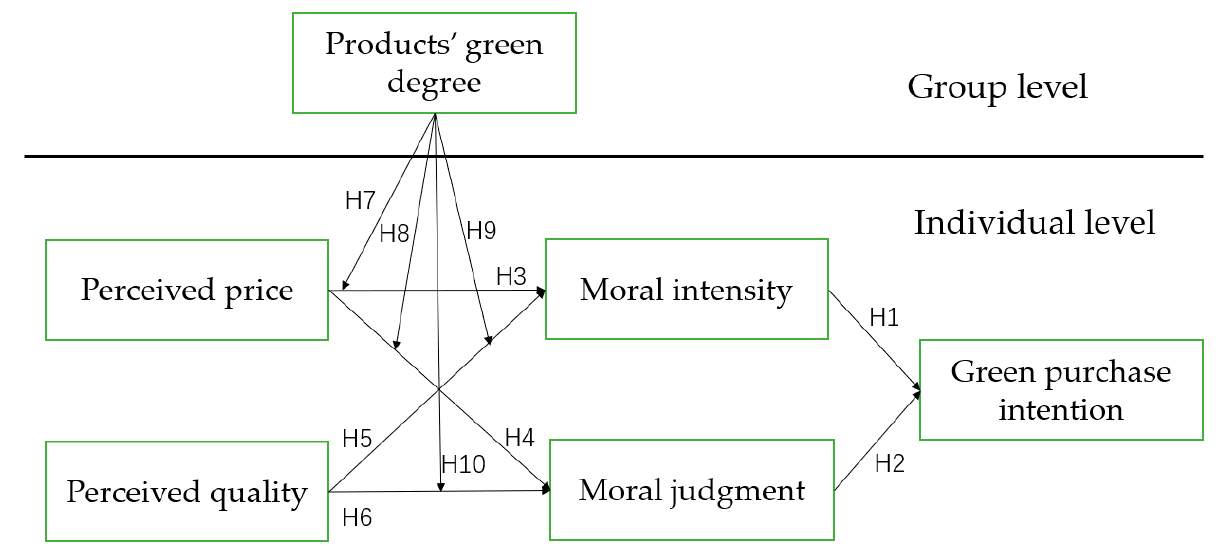
Figure 1. Research Figure 1. Research framework.